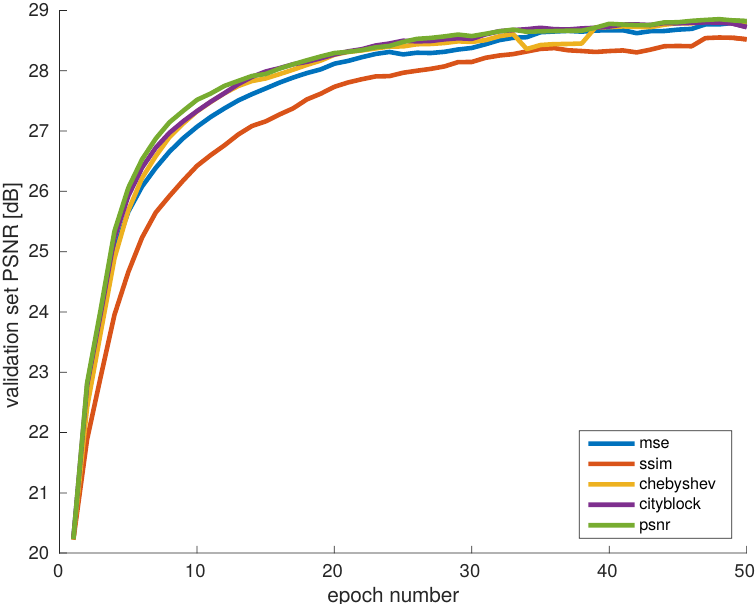
Figure 8. Evaluation of different error metrics for adaptive data selection. The numerical error metrics do not significantly affect the quality of the generated dataset. SSIM as a perceptual metric pefrorms slightly worse, due to the differences in the definition of image quality between SSIM and PSNR.